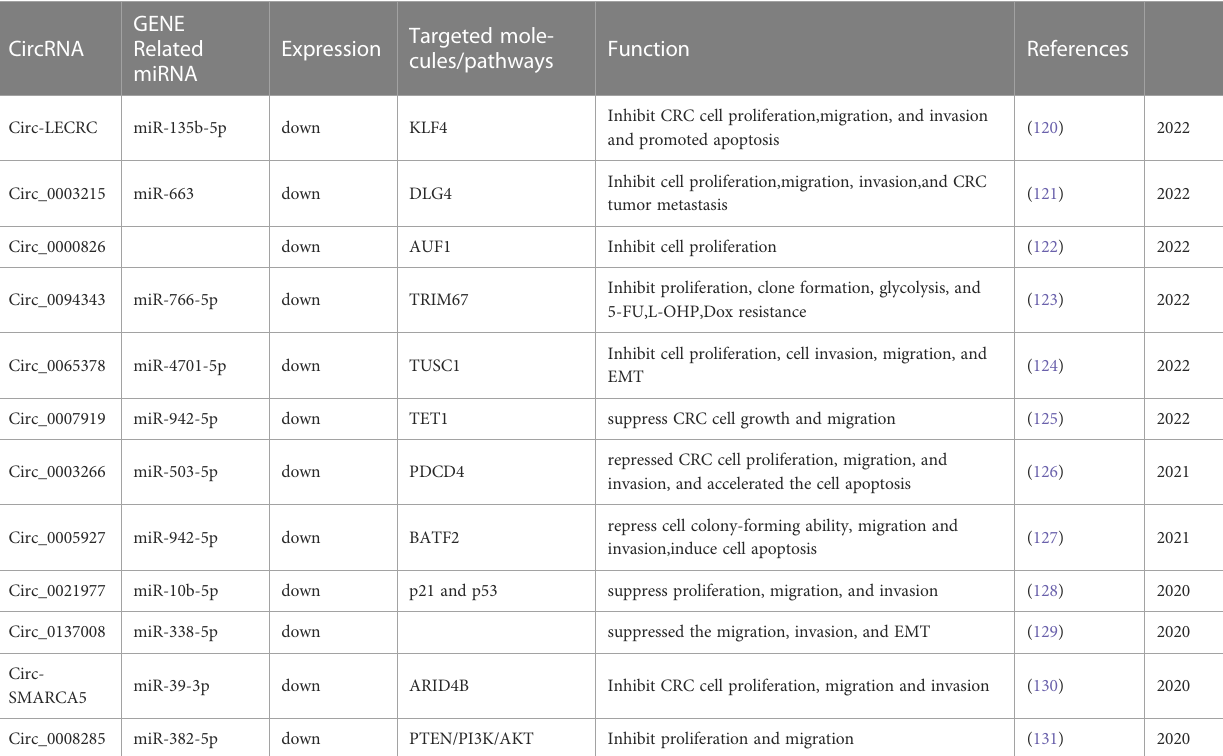
TABLE 2 Down-regulated circRNA in